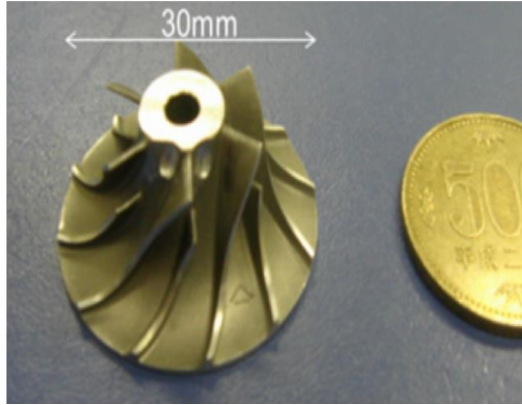
Figure 3. Institute of Applied Energy (IAE) test component